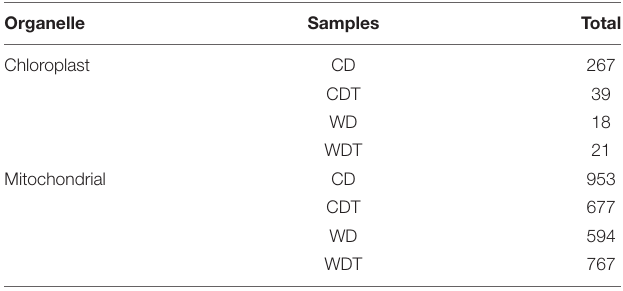
TABLE 2 | Summary of identified RNA editing sites in chloroplast and mitochondrion genome of rice under alkaline stress. Organelle